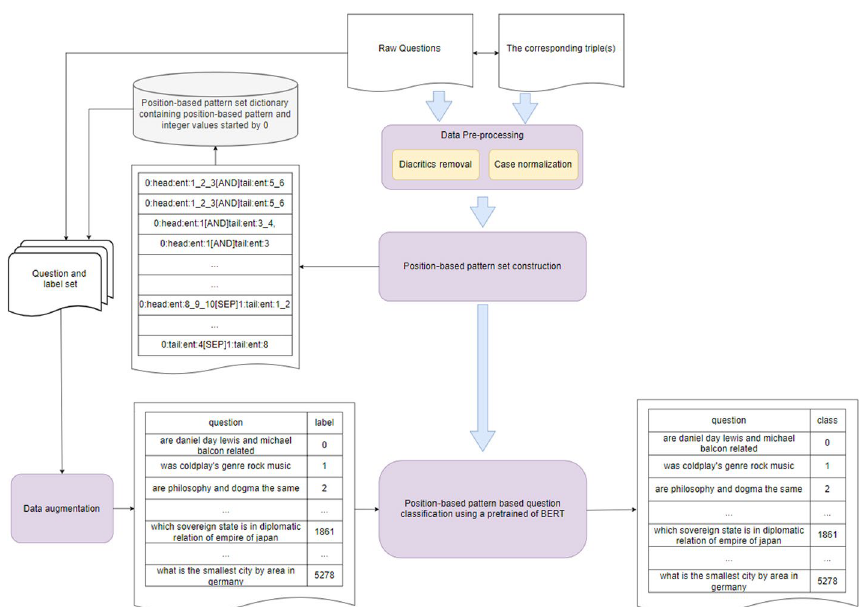
Fig. 4 The proposed of entity detection via position-based